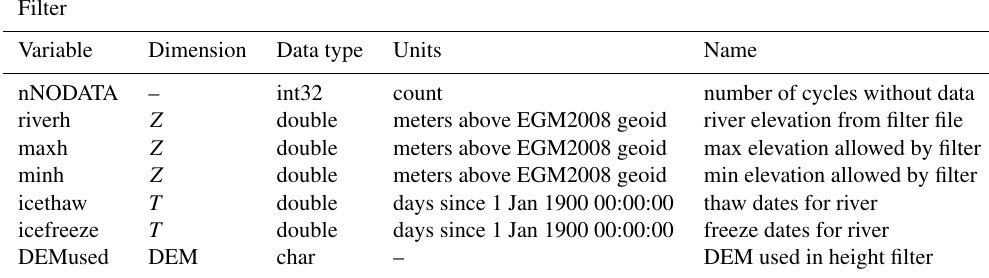
Table A5. These are the filter data; nNODATA gives the number of cycles that have no data because of a lack of data in the GDR and/or data that are filtered out. riverh gives the river elevation extracted from a 30arcsec DEM of the region. This is used for the height filter. maxh and minh are the upper and lower bounds of river heights included in the filtered data; we set an elevation of + 15m or − 10m from the DEM river elevation as a first pass, and we then removed any data that was 5m below the 5th percentile of river stage heights. icethaw and icefreeze are the thaw and freeze dates, respectively, for the years included in the altimetry dataset. The DEM used refers to the DEM that the baseline height was taken